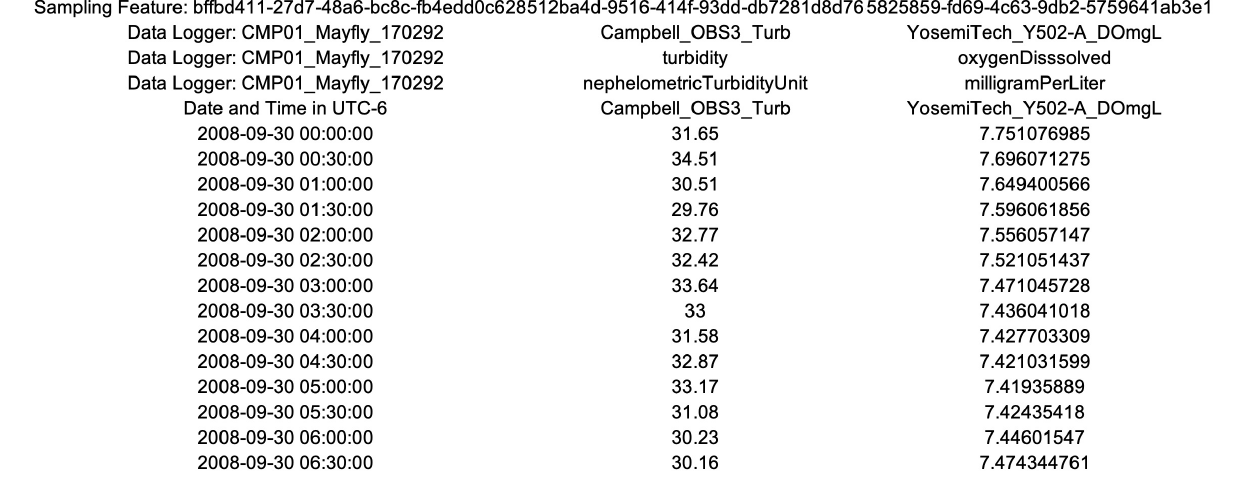
Frontiers in Earth Science |